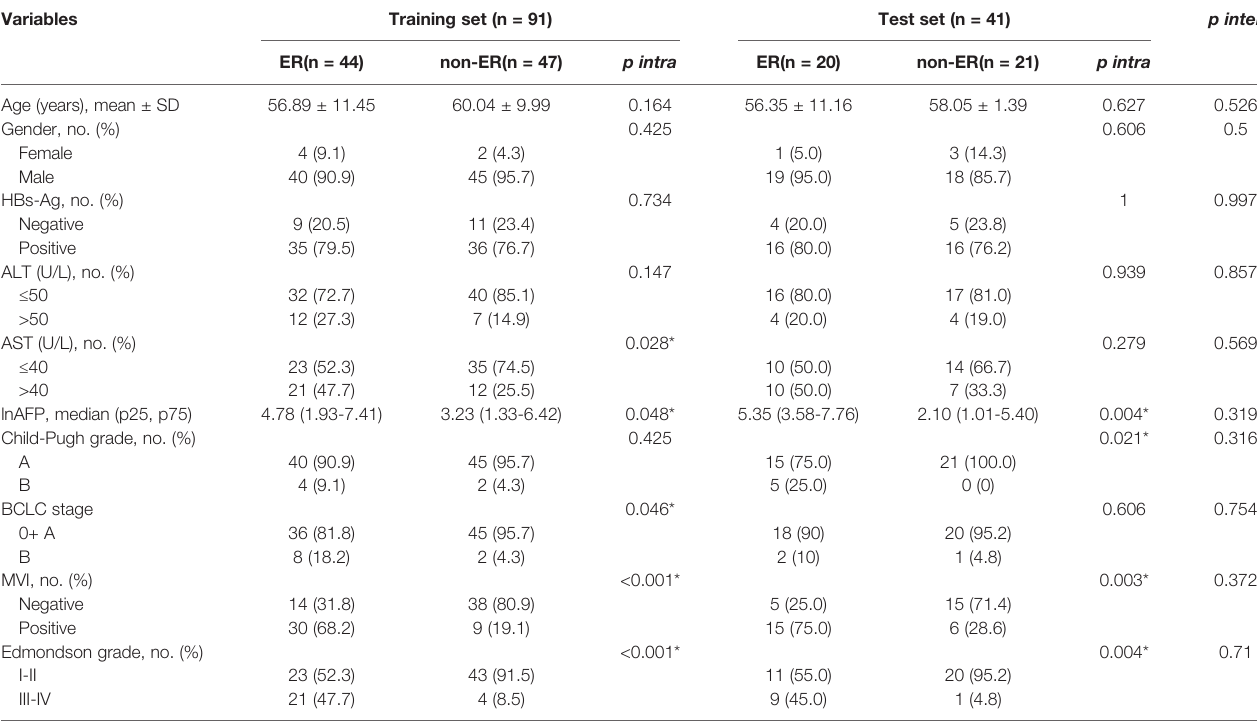
TABLE 1 | Demographic and clinical characteristics of HCC patients in the training and test sets.